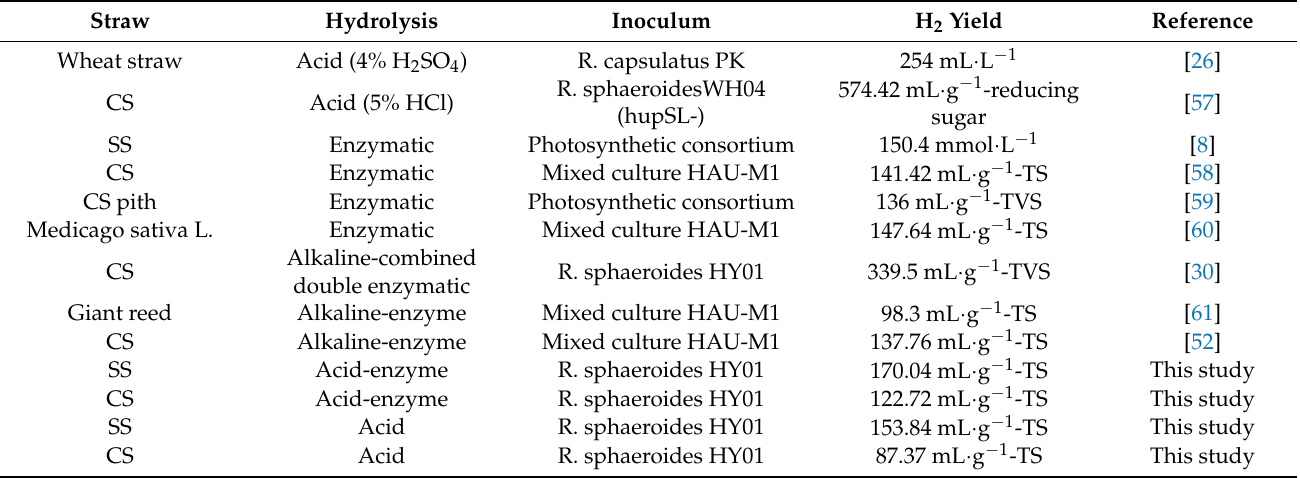
Table 4. Comparison with other photo-fermentative hydrogen production using straws.